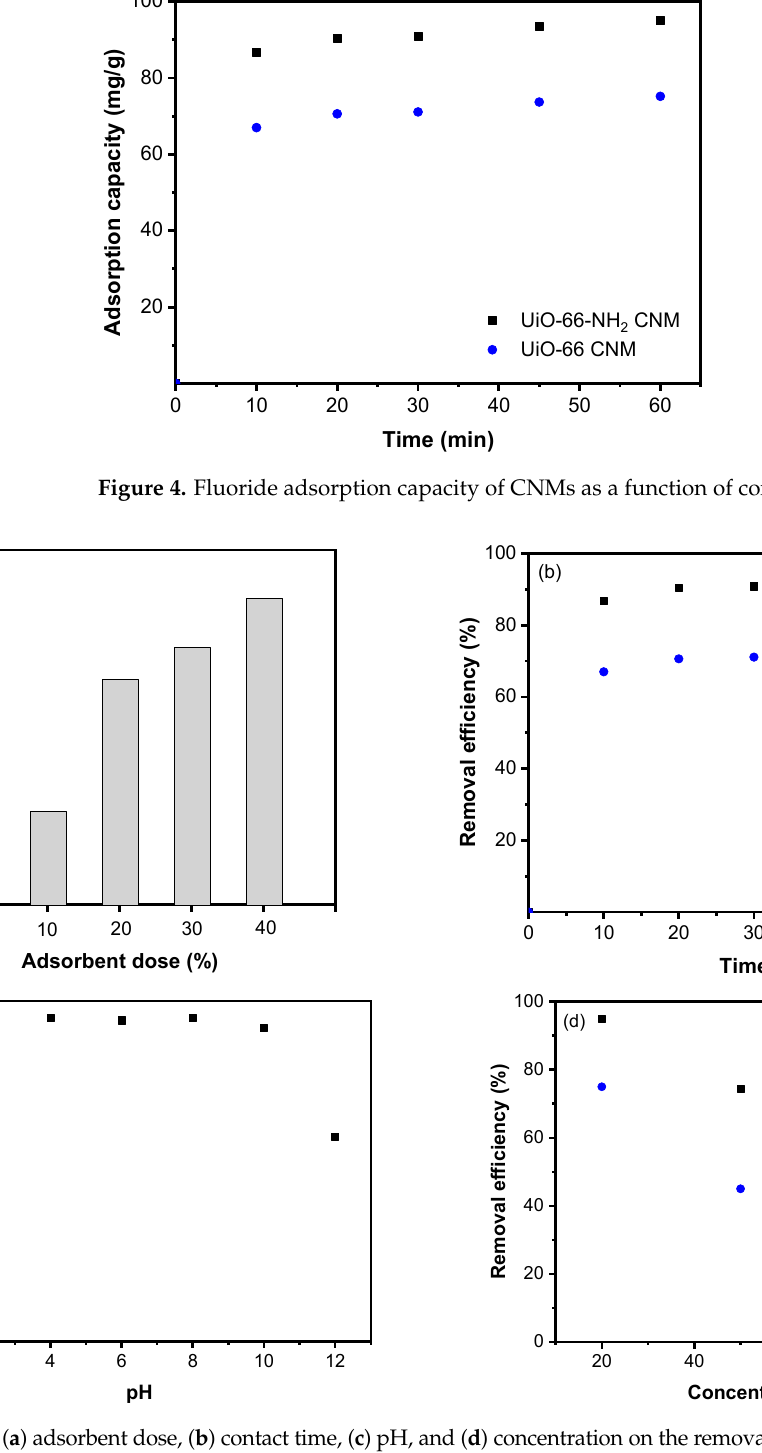
Figure 5. Effect of ( a ) adsorbent dose, ( b ) contact time, ( c ) pH, and ( d ) concentration on the removal efficiency of UiO-66-NH 2 . Table 2. Comparison of the fluoride removal performance with other reported adsorbents. Material